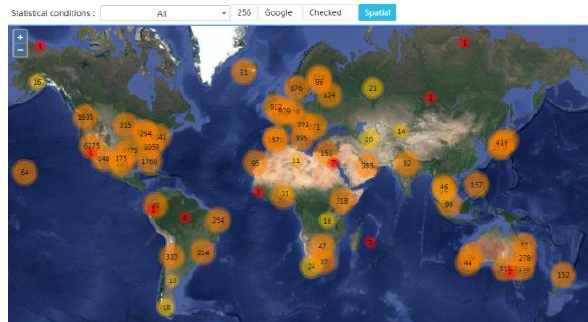
Figure 11. Spatial distribution of the V-RSIR dataset